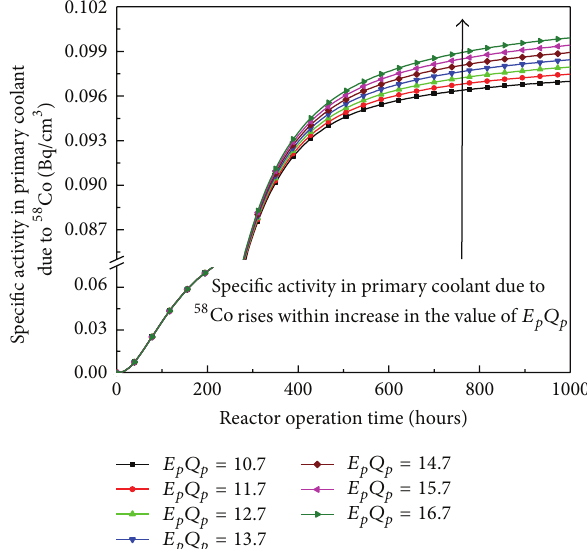
Figure 12: Variation in specific activity of 58 Co in primary coolant of PWR with different values of 𝐸 𝑃 𝑄 𝑃 .